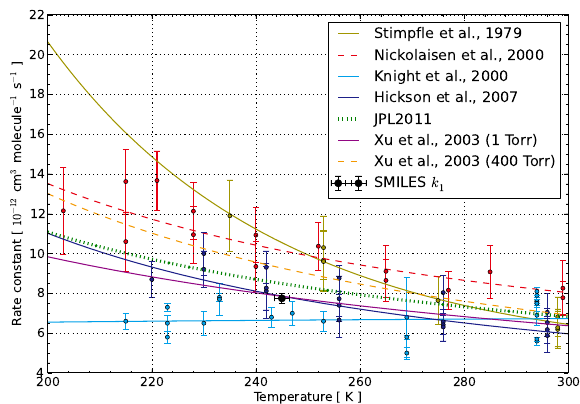
Fig. 7. Comparison with previous work. The dots and lines represented the experimental values from Stimpfle et al. (1979) (yellow), Knight et al. (2000) (red), Nickolaisen et al. (2000) (cyan), and Hickson et al. (2007) (blue). Further lines show the calculation values from JPL 2011 recommendation (Sander et al., 2011) (green) and the ab initio calculation (Xu et al., 2003) (purple (1Torr) and orange (400Torr)). The black dot is the value of the SMILES k 1 . Solid and dashed lines are k 1 values at higher pressure (50–700Torr) and lower pressure ( (cid:20) 5.0Torr), respectively.